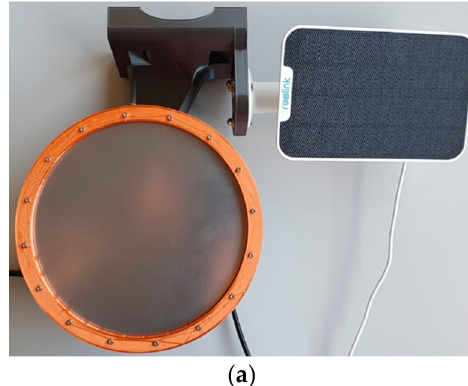
Figure 8. ( a ) Top view of the sensor with solar module; ( b ) Side view of the sensor with 25° inclined mounting base.